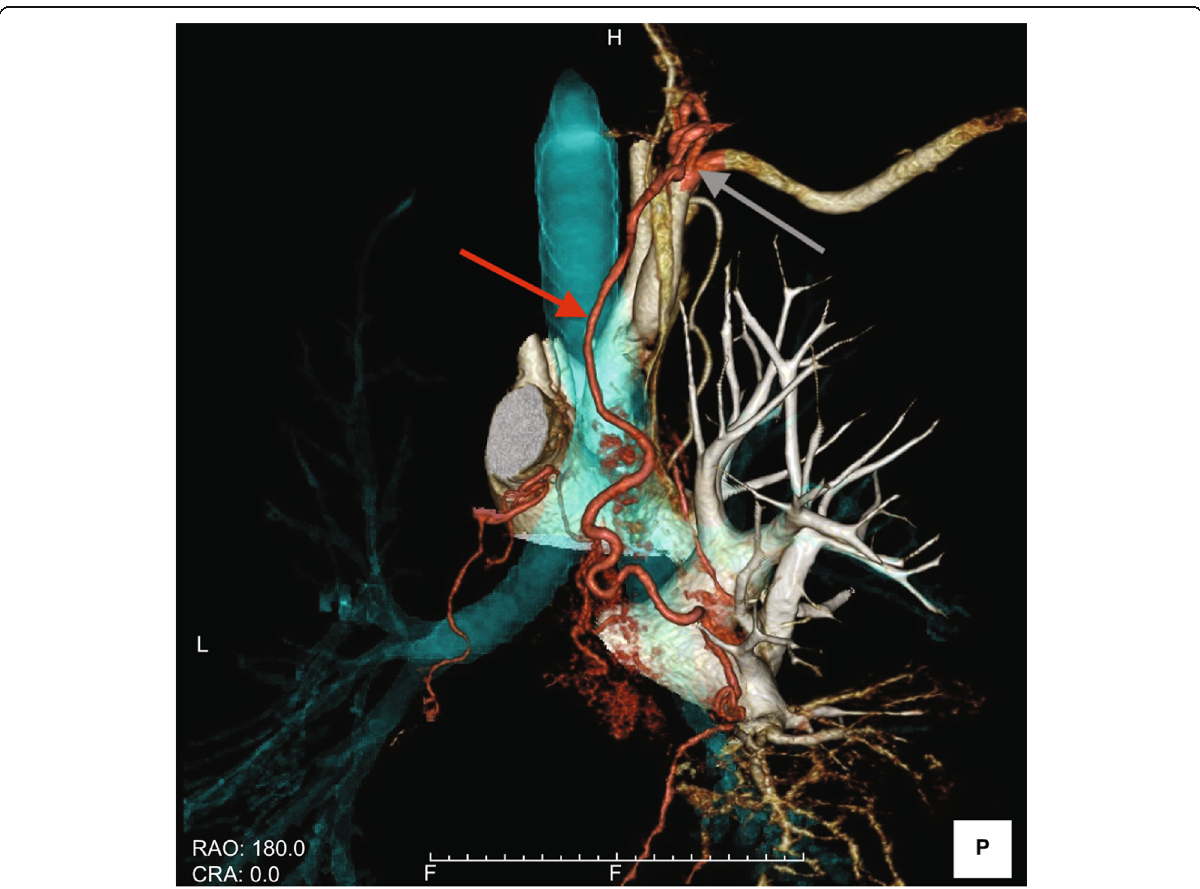
Fig. 2 Volume rendering reconstructed image of multidetector computed tomography angiography shows a hypertrophic ectopic right bronchial artery (red arrow) arising from the right thyrocervical trunk (gray